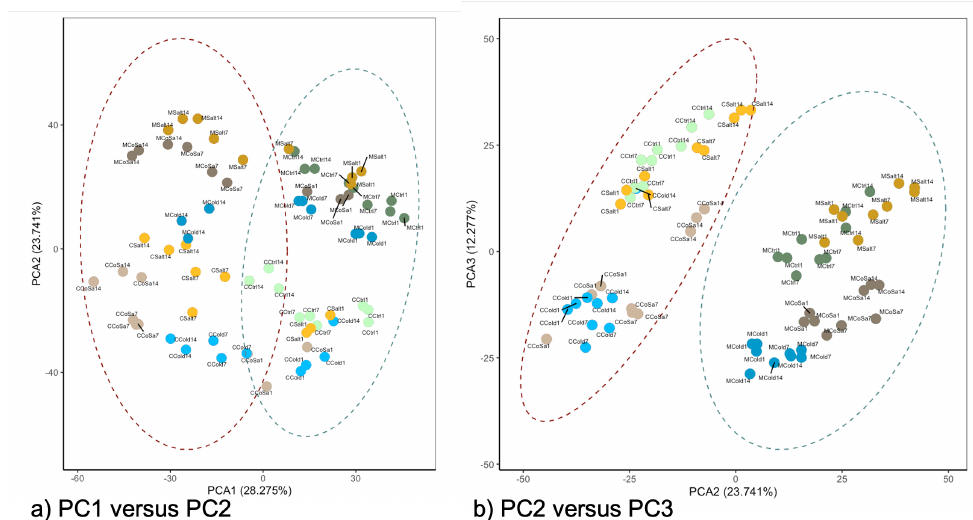
Figure A2. PCA from a combined analysis of Mazurka and CAP1035. RNASeq reads were mapped to an artificial transcriptome comprising both transcriptomes coming from Mazurka (M) and CAP1035 (C) (see also methods). Shown in ( a ) is the principal component 1 (PC1) versus principal component 2 (PC2), indicating that the highest variation in the combined analysis is coming from the harvest time point as indicated by the final number. In ( b ), the principal component 2 (PC2) is shown over principal component 3 (PC3), indicating that the next level of variation is influenced by the species (starting M versus starting C). Control samples (Ctrl) are indicated in green, cold samples (Cold) in blue, salt samples (Salt) in orange, and samples with a combination of salt and cold (CoSa) in brown.